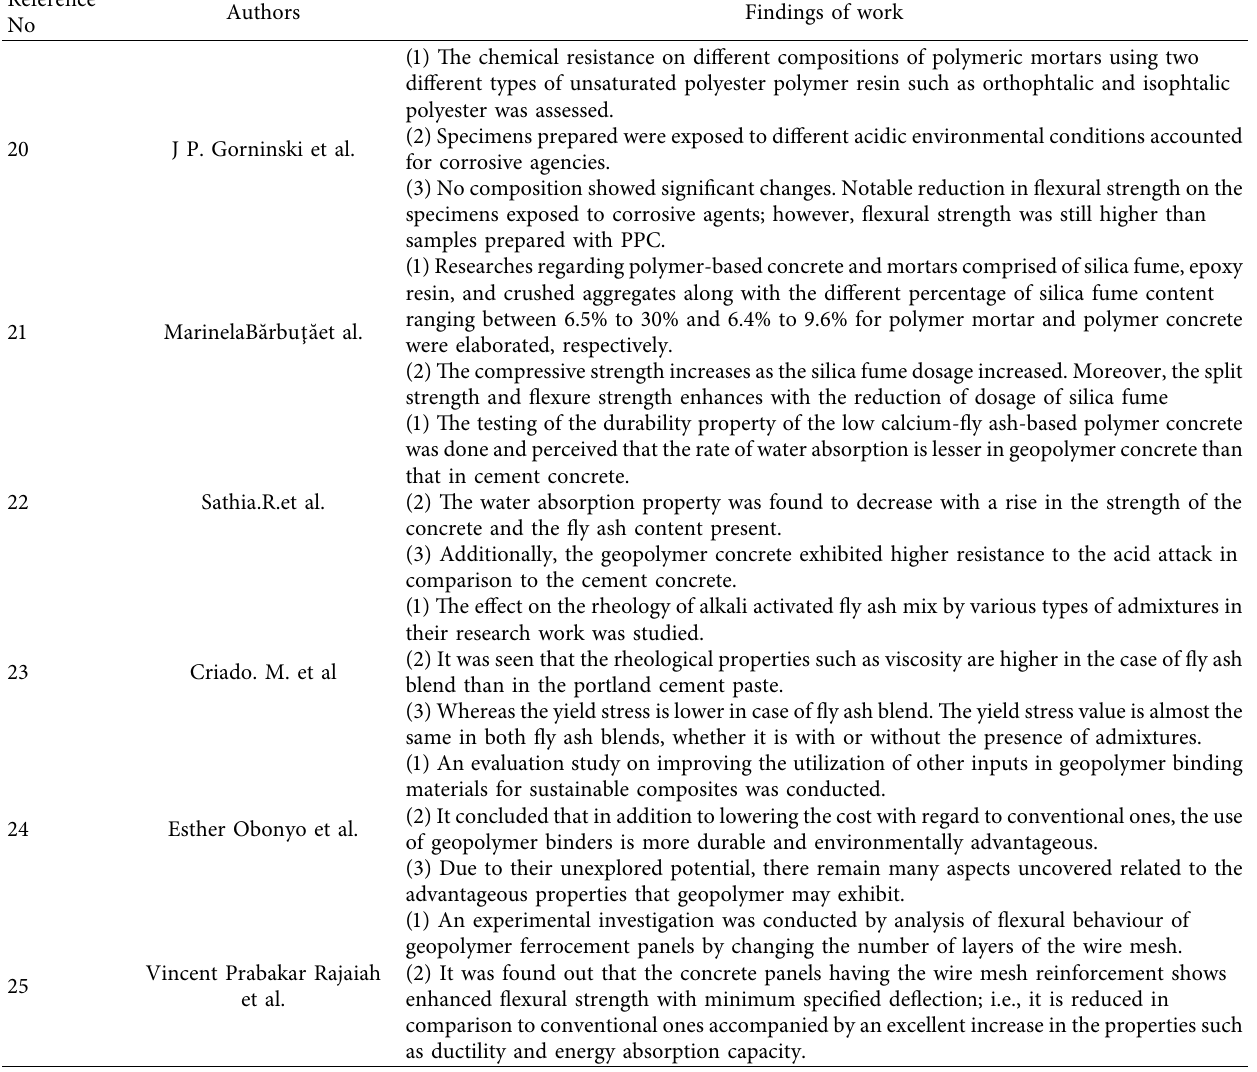
Table 4: Summary of previous work related to polymer-based ferrocement